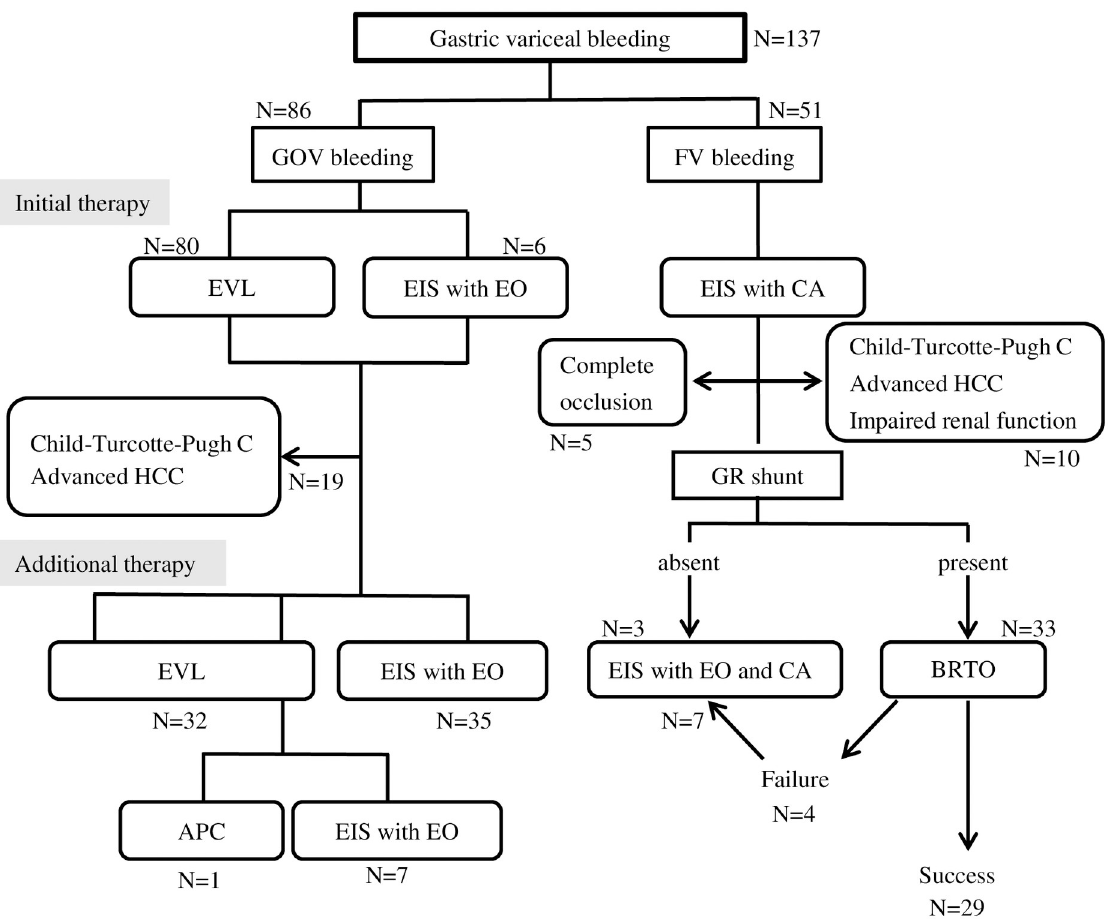
Fig 1. Therapies adopted in the 137 enrolled patients who presented with gastric variceal bleeding. EVL, Endoscopic variceal ligation; EIS, endoscopic injection sclerotherapy; EO, ethanolamine oleate; CA, cyanoacrylate; HCC, hepatocellular carcinoma; CKD, chronic kidney disease; GRS, gastrorenal shunt; BRTO, balloon-occluded retrograde transvenous obliteration; APC, argon plasma